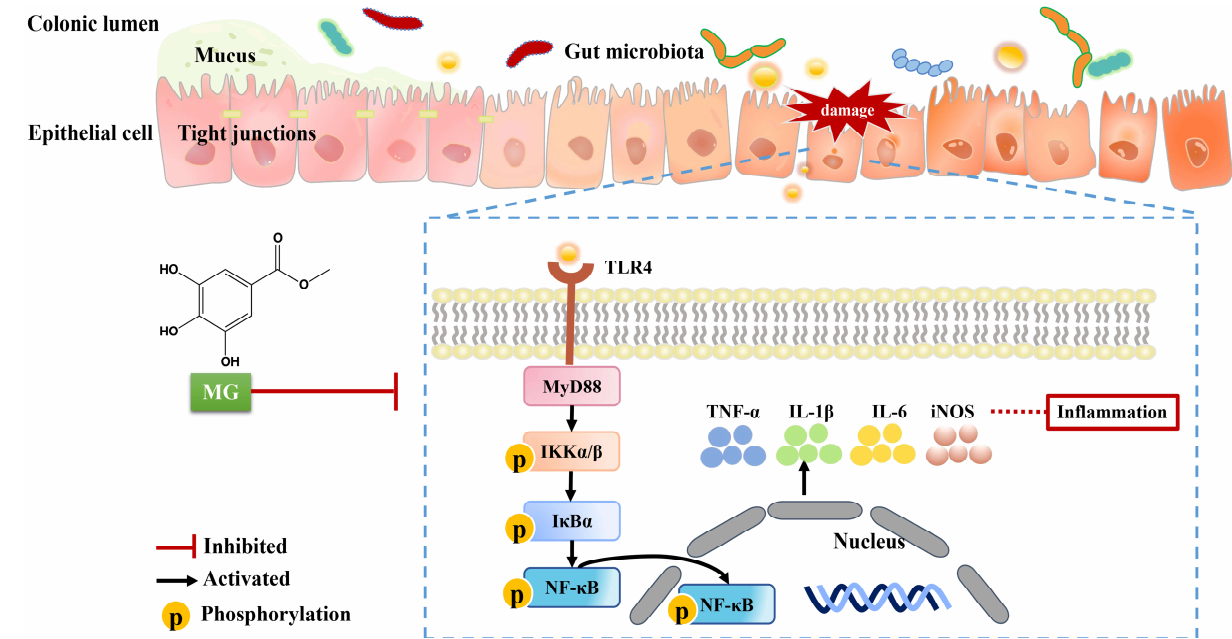
Figure 9. Action mode and potential mechanism of MG in treating UC.